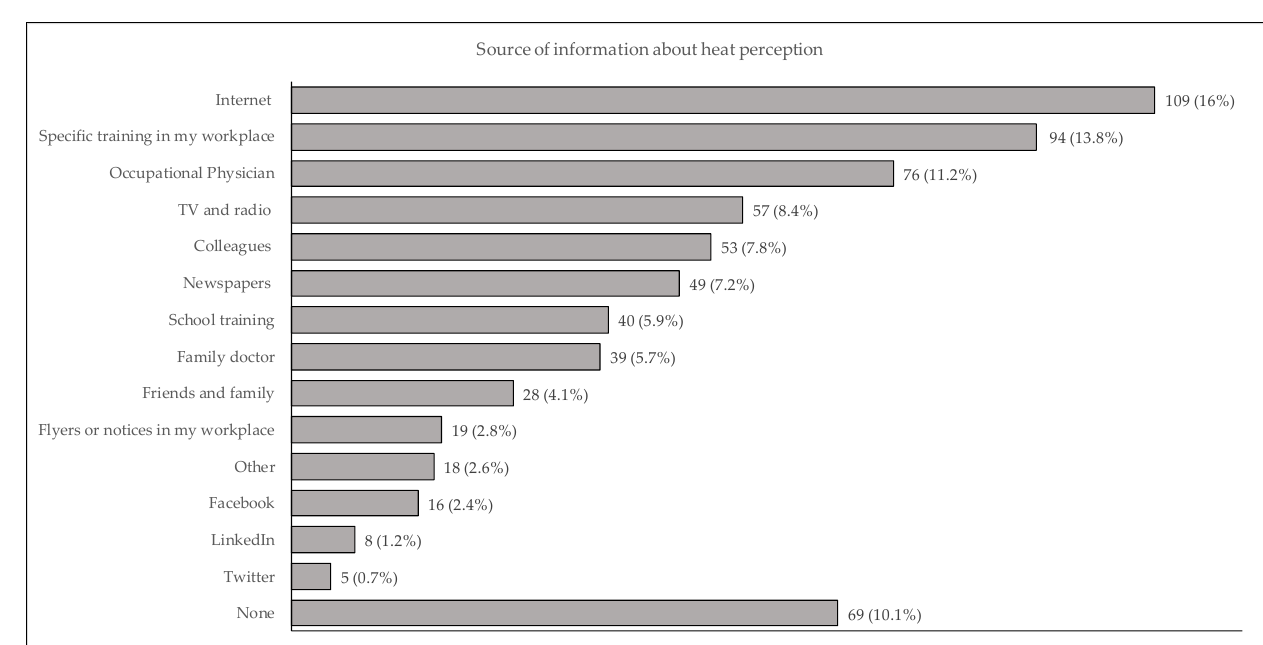
Fig 1. Air Temperatures anomalies in Italy during the period June-October 2020 (A), July (B) and August 2020 (C) compared to the reference period 1981-2010. Data obtained from https://psl.noaa.gov/cgi- bin/data/composites/printpage.pl, accessed on 27 January 2022.